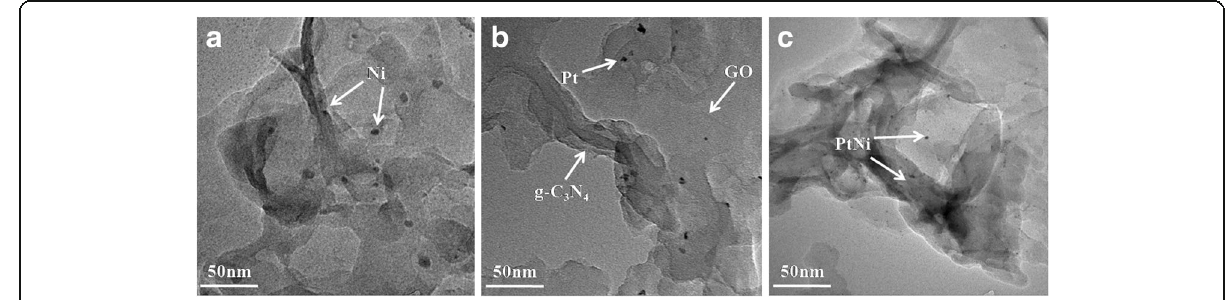
Fig. 2 TEM images of g-C 3 N 4 /Ni/GO-0.5% ( a ), g-C 3 N 4 /Pt/GO-0.5% ( b ), and g-C 3 N 4 /PtNi/GO-0.5% ( c